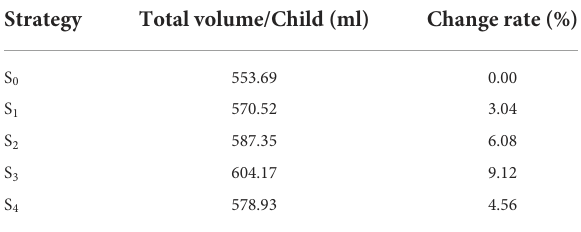
TABLE 1 Vaccine volume calculation tool to calculate the volume change of NIP vaccine for each child.